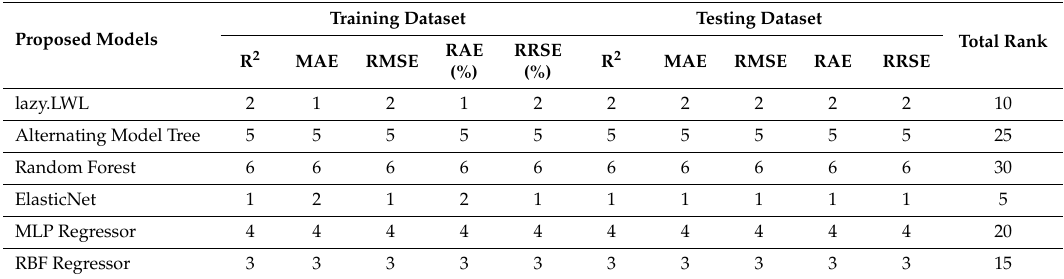
Table 5. Total ranking of proposed machine learning